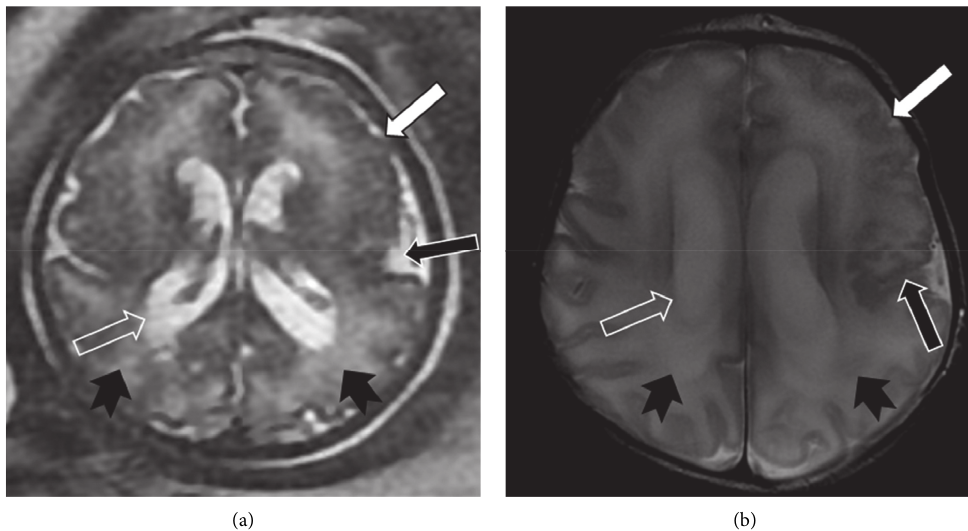
Figure 3: CMV infection. Gestational age: 35 weeks. (a) Fetal Axial SSFSE T2. (b) Postnatal cerebral MRI at 8 days of life, axial FSE T2. The presence of diffuse affectation of the white matter of parietal predominance (solid black arrowhead) with mild ventriculomegaly (empty white arrow) is shown. Fetal MRI provided useful information for perinatal management and prognosis over fetal ultrasound by detecting left frontal (solid white arrow) and left Sylvian fissure (solid black arrow) polymicrogyria not visible in the fetal